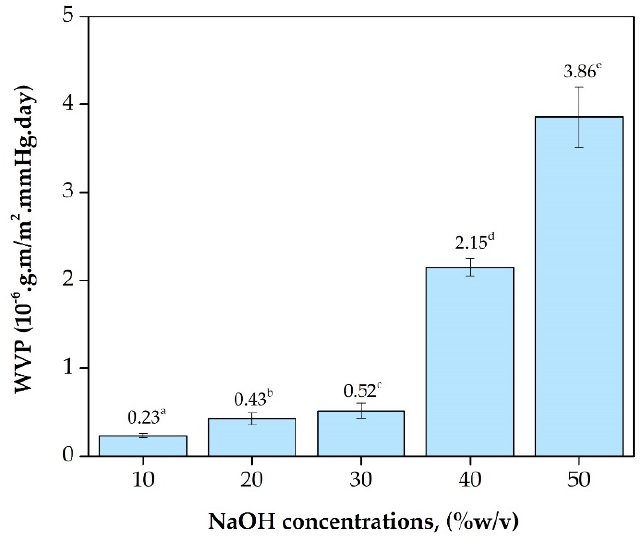
Figure 8. The effect of water vapor permeability (WVP) on CMSr films synthesized with 10%, 20%, 30%, 40%, and 50% NaOH concentrations. Different letters (a, b, c, d, e) indicate significant differences between CMSr films synthesized with various NaOH concentrations.